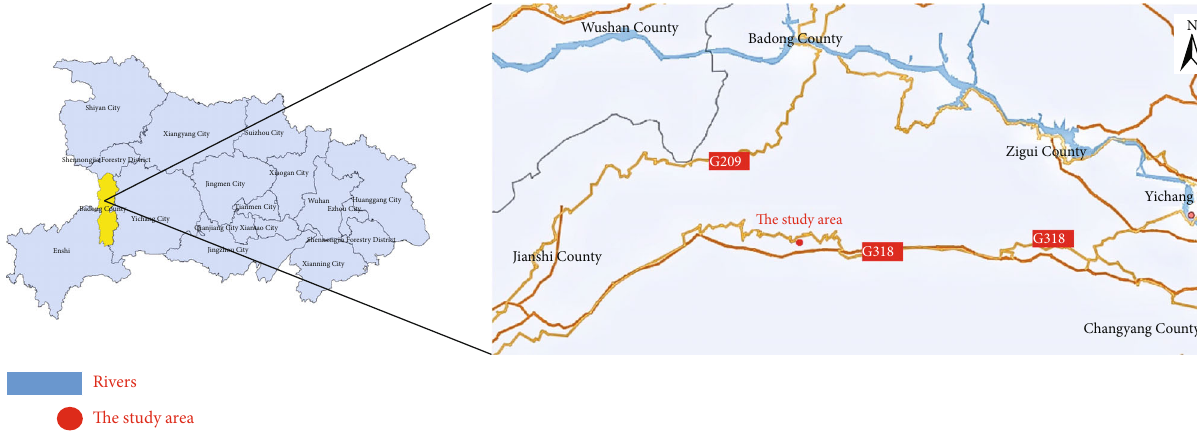
Figure 1: Geographical location of the study area.